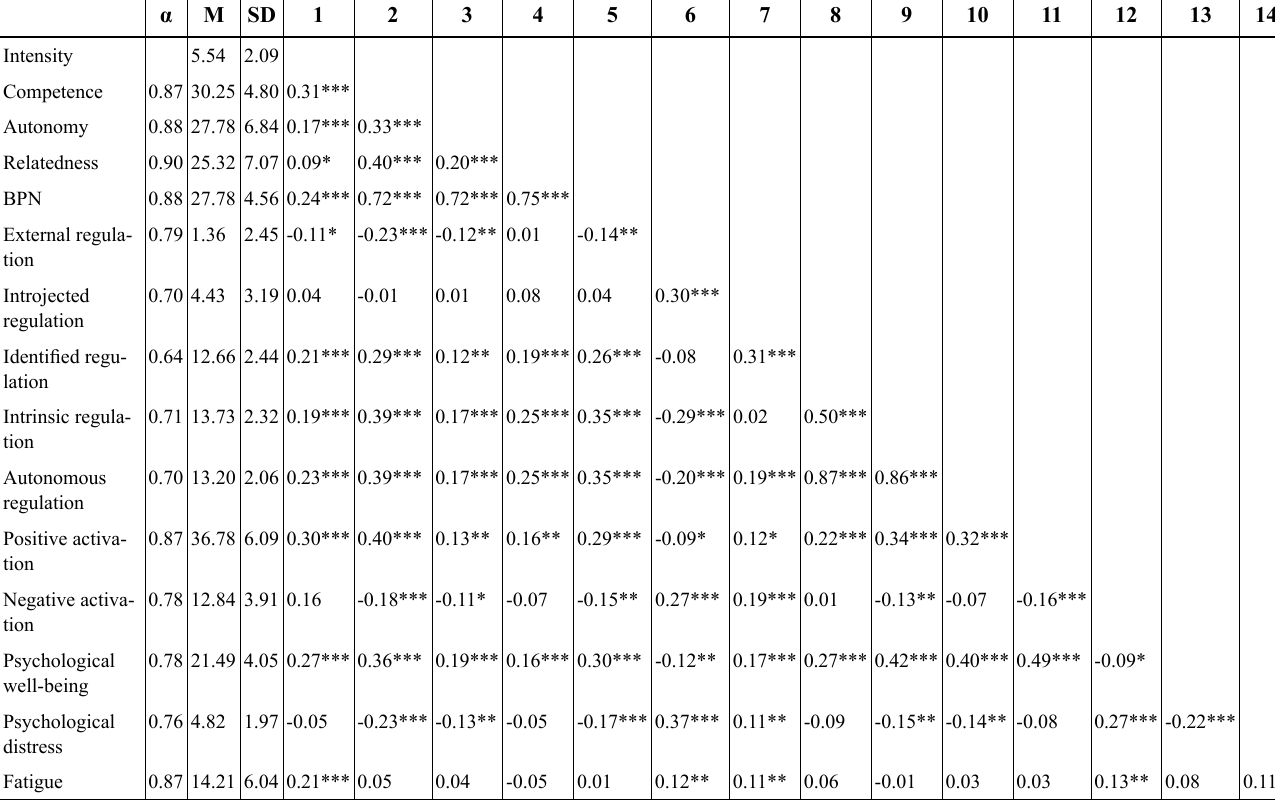
Table 1. Mean, standard deviation and correlation analysis of intensity, basic psychological needs, motivational regulations and emotional response α M SD